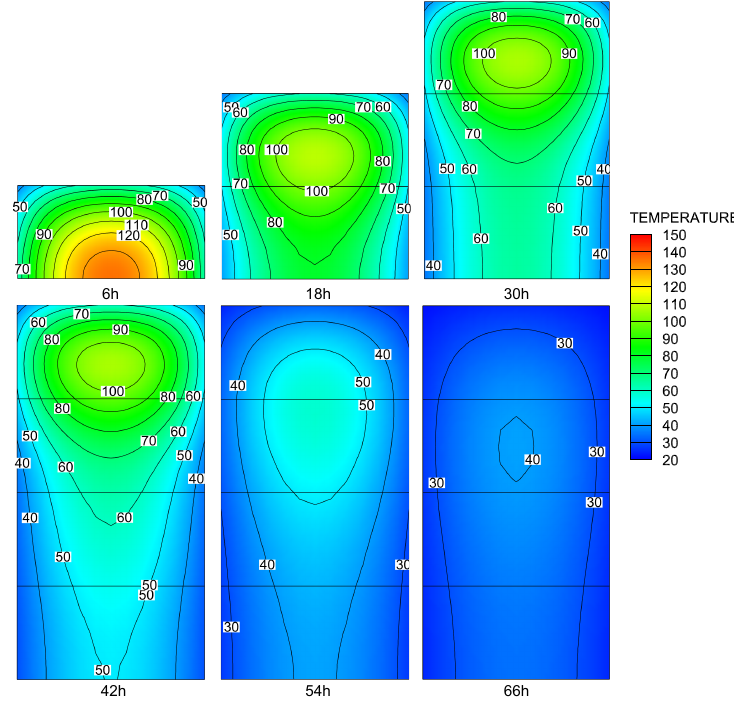
Figure 7. The temperature contour of Example 2